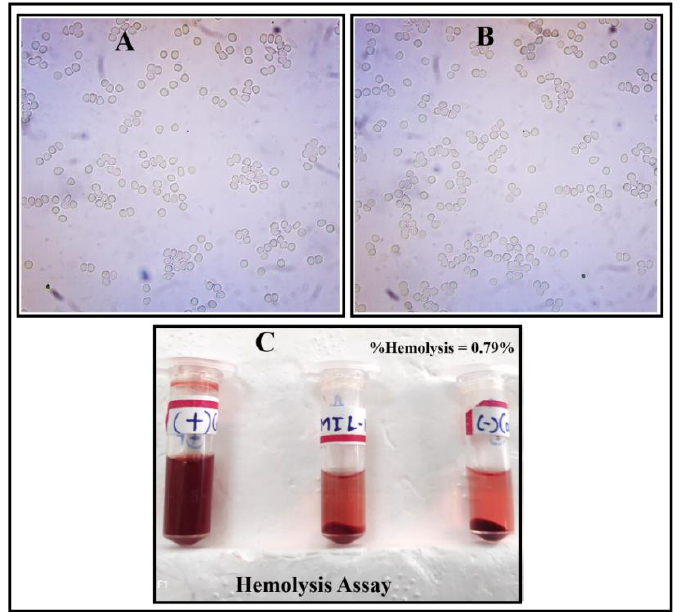
Figure 14. Interaction of SM-MIL with erythrocytes. ( A , B ) Morphology of RBC under Motic micro- scope after treatment with SM-MIL. ( C ) Haemolysis assay of SM-MIL depicting critical safe value. Table 2. Average body weight of rats treated with different doses of SM-MIL. Weight (g) of Rats on Different Days Dose of SM-MIL (mg/kg)